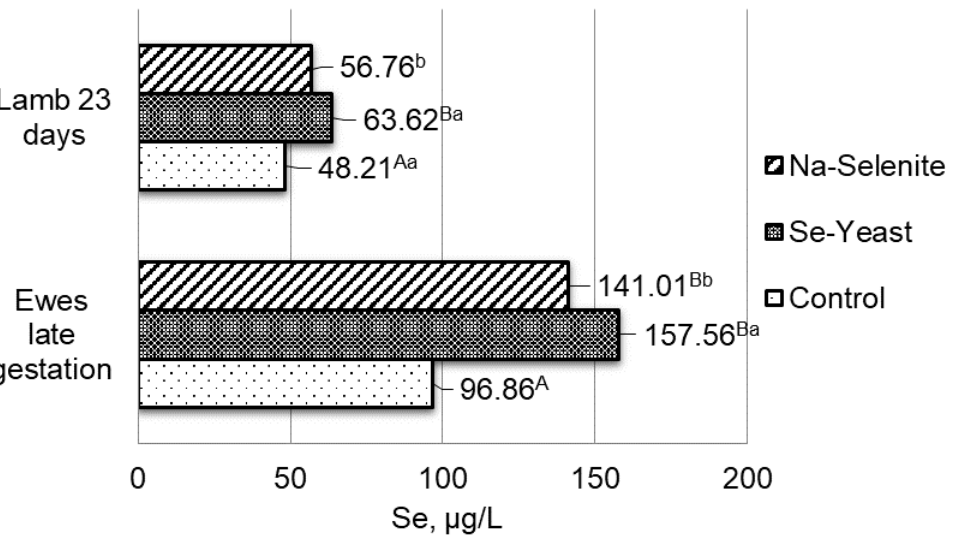
Figure 1. Concentration of selenium in whole blood of late-gestation ewes and 23-day-old lambs. I-control group; II-addition of organic selenium supplement; III-addition of inorganic selenium supplement; Se-selenium; a, b, p < 0.05; A, B, p < 0.01 differences between treatments.